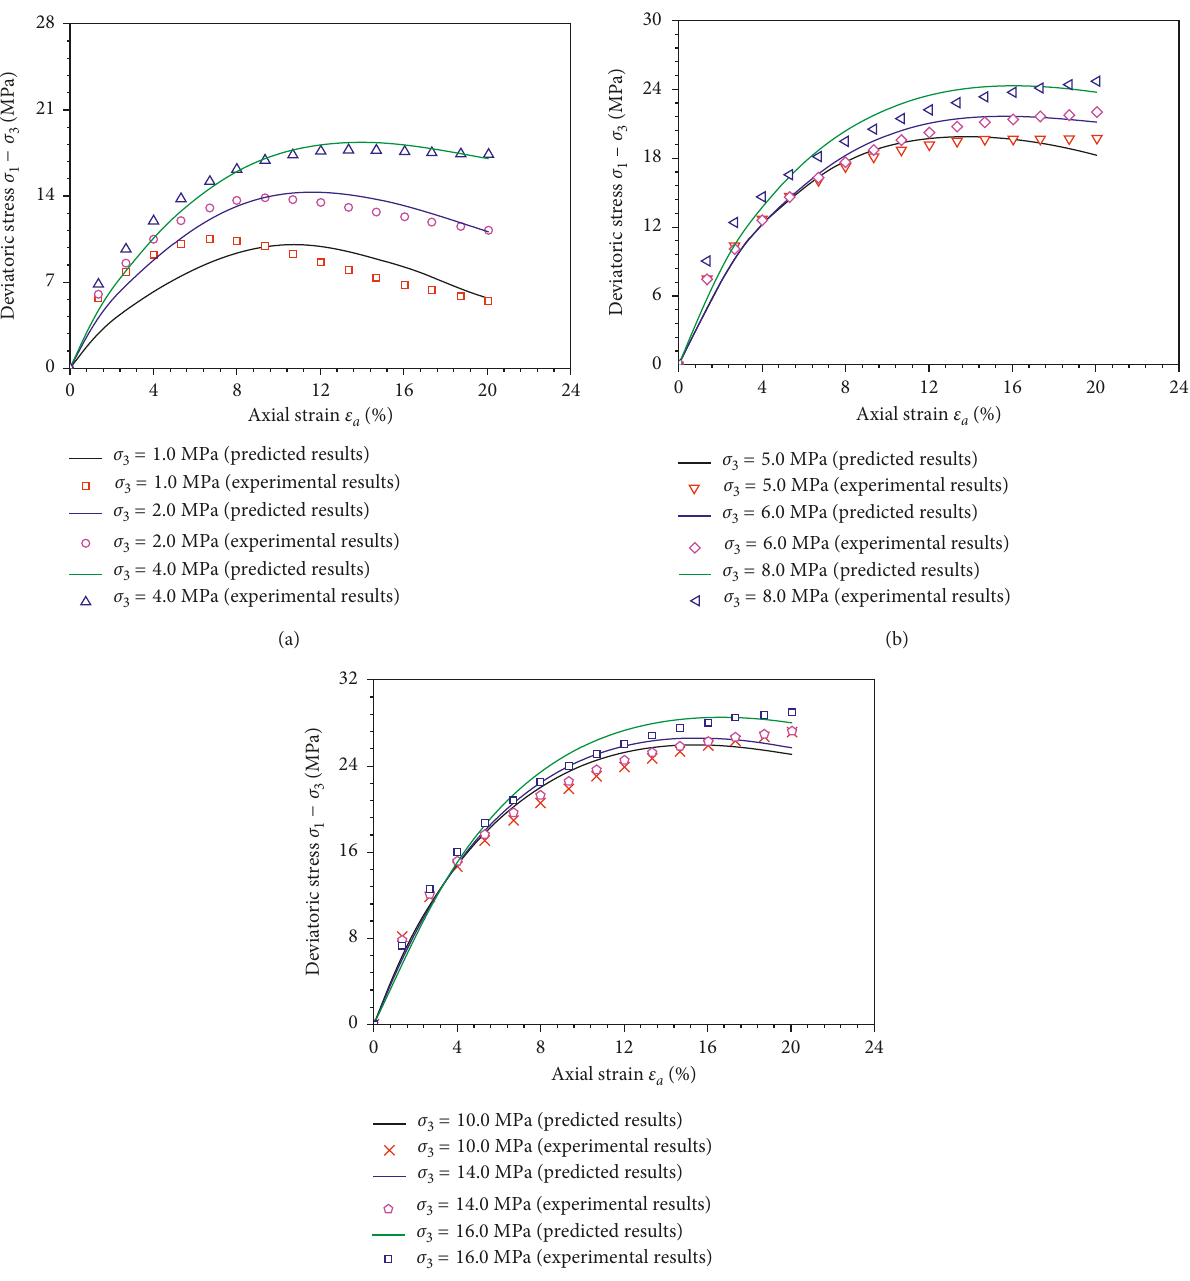
Figure 13: Comparisons between test data and predicted results of deviatoric stress-axial strain under different confining pressures: (a) 1.0–4.0 MPa, (b) 5.0–8.0 MPa, and (c)